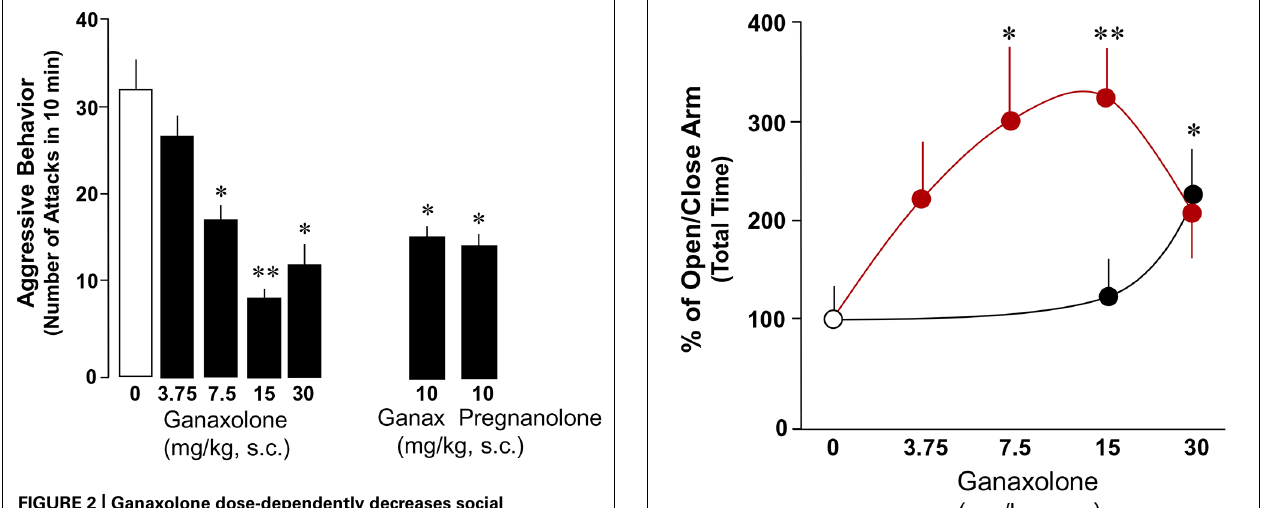
FIGURE 2 | Ganaxolone dose-dependently decreases social isolation-induced aggression of resident mice toward a same-sex intruder. Dose–response curve resulted in an EC 50 dose of 10 mg/kg of ganaxolone. Equimolar doses of ganaxolone and the GABA A receptor active, ALLO isoform, pregnanolone were equipotent in decreasing aggressive behavior in SI mice. Data represent the mean ± SEM of 8–10 SI mice. * P < 0.01; ** P < 0.001, when compared with vehicle-treated (0) mice.